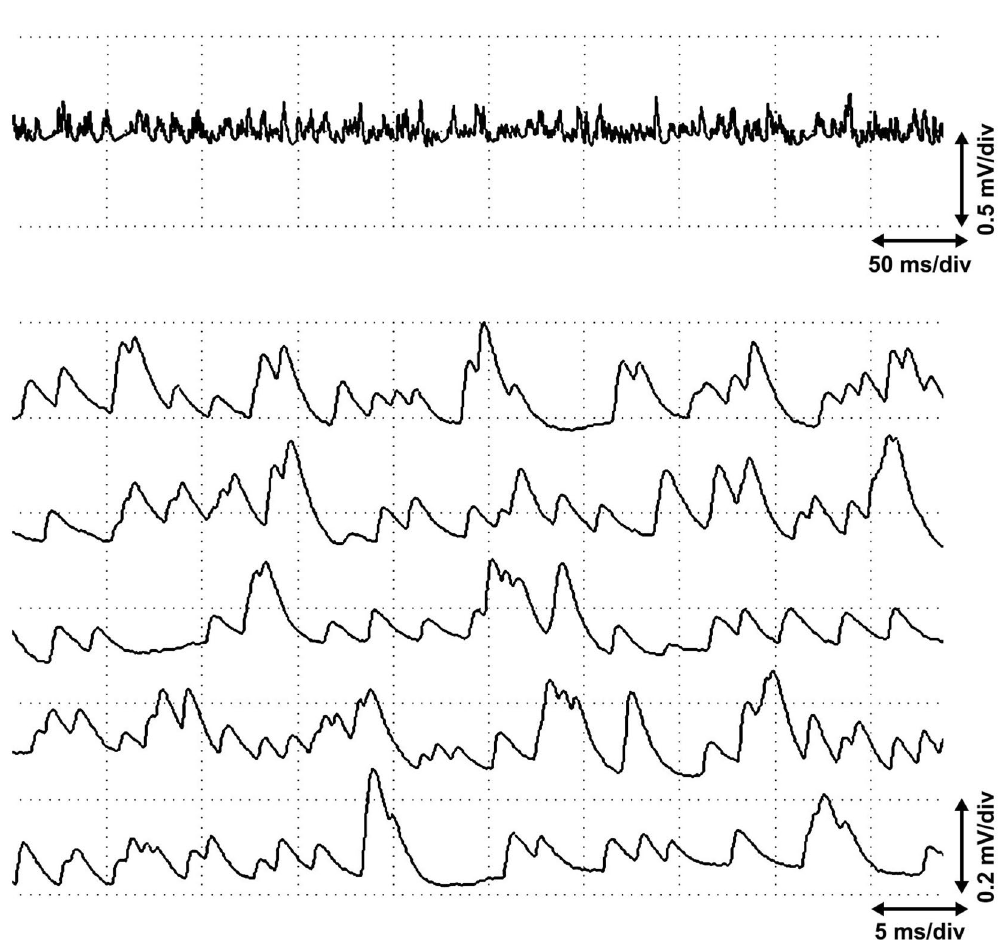
Figure 3. A long sequence of miniature end plate potentials without end plate spikes. Numerous large and partially stratified miniature end plate potentials at the end plate zone of the biceps brachii muscle without any elicited postsynaptic action potentials (cf. 6 ) in an active site without end plate